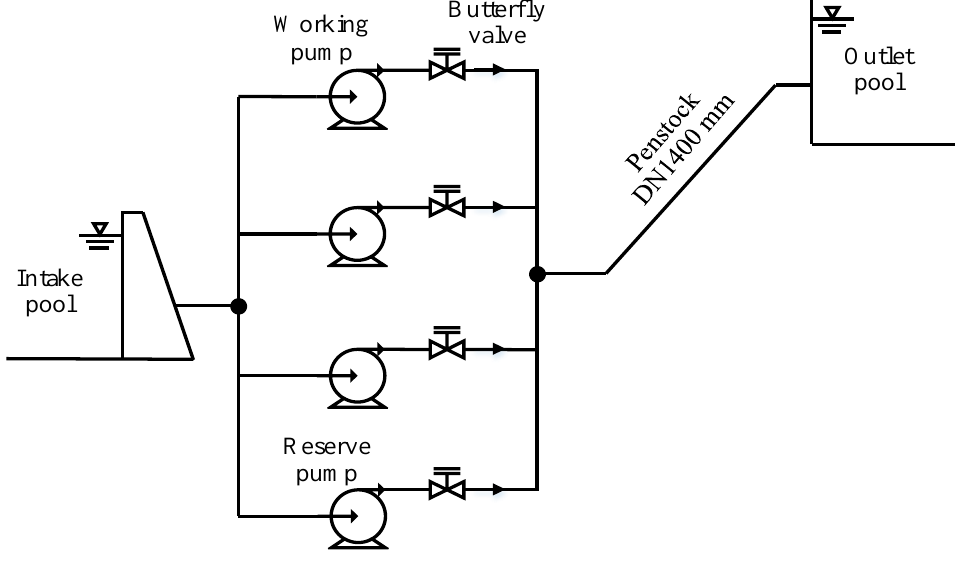
Figure 12. Schematic diagram of pump station layout [39].